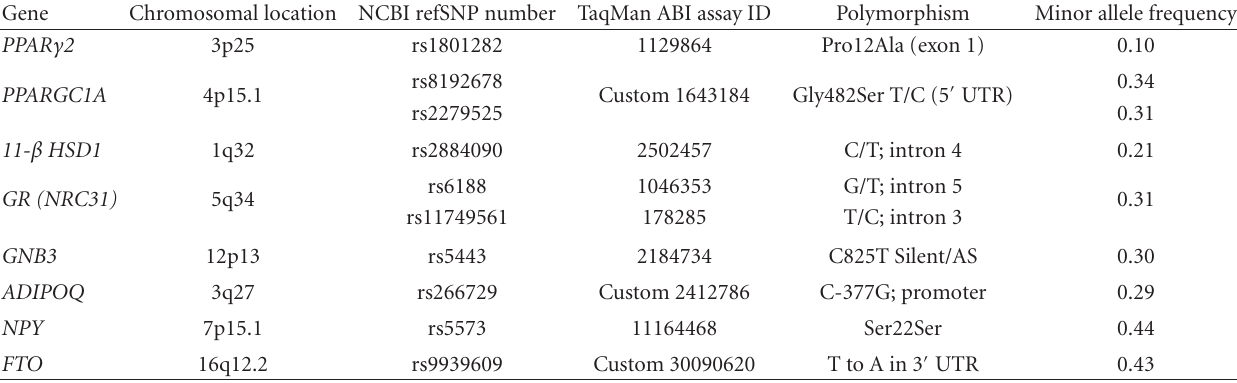
Table 1: Candidate genes and SNPs analyzed for association with excess weight gain with intensive diabetes therapy. Genotyping was performed using ABI TaqMan assays with the indicated ABI identification numbers (custom, made to order). Minor allele frequencies are for Caucasian populations derived from published data and the SNP database (http://www.ncbi.nlm.nih.gov/SNP/). PPARG , peroxisome proliferator activated receptor γ ; PPARGC1A , peroxisome proliferator-activated receptor γ coactivator-1 α ; HSD11B1 , 11 β -hydroxysteroid dehydrogenase 1; GR ( NRC31 ), glucocorticoid receptor; GNB3, G protein β 3 subunit; ADIPOQ , adiponectin; NPY , neuropeptide y, FTO (aliases KIAA1752 , MGC5149 ), fat mass, and obesity-associated